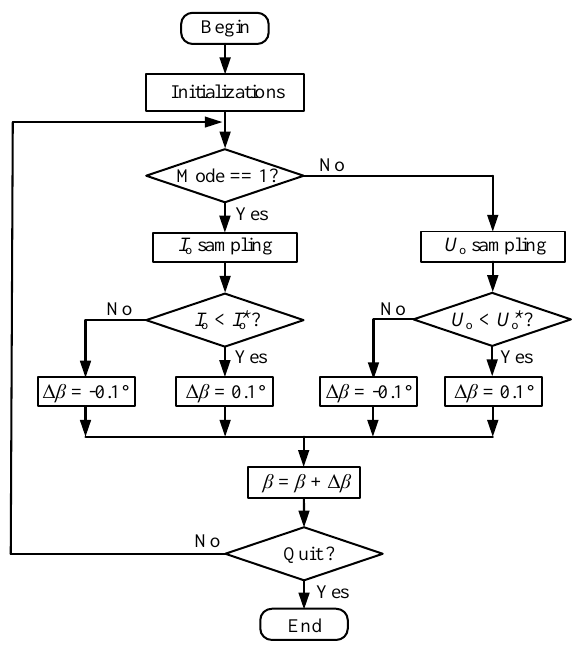
Figure 6. Algorithm flowchart of DPC receiver.